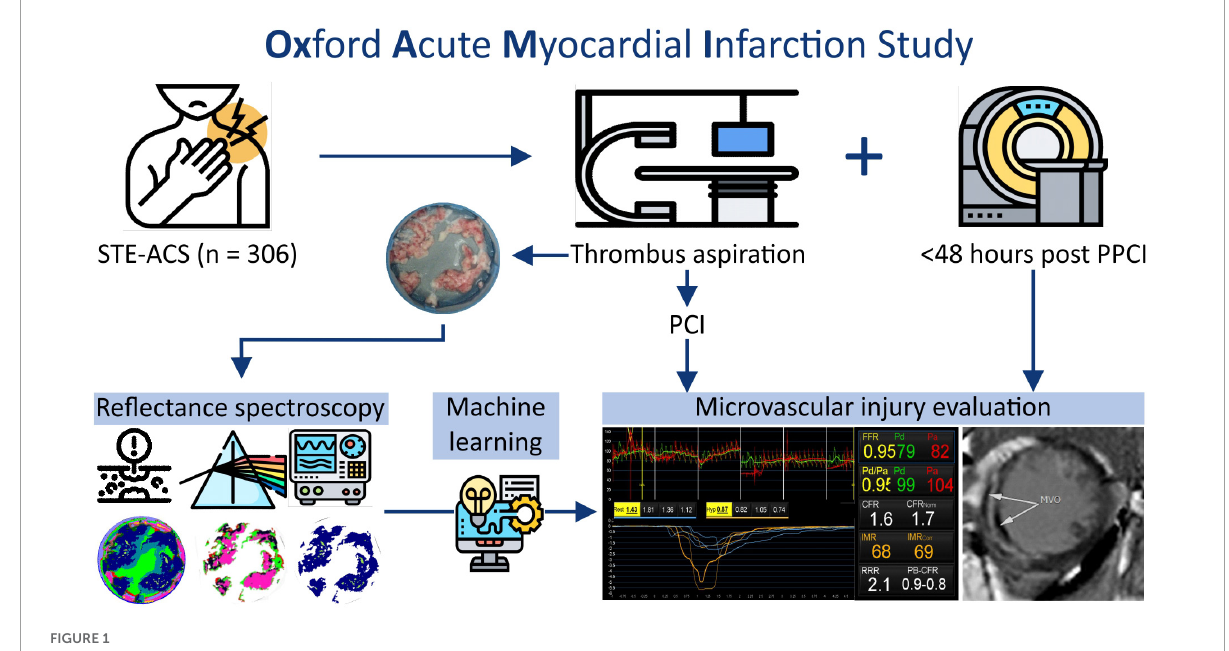
FIGURE1 Experimental